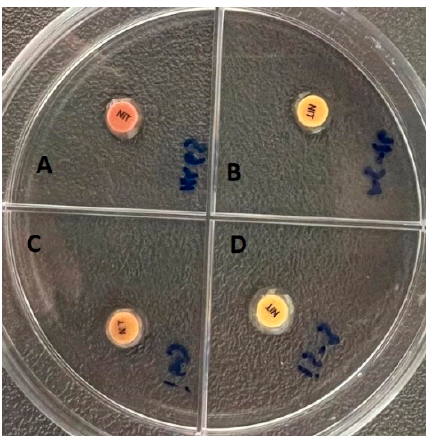
Figure 5. Chromogenic disk assay: ( A , C ) Beta-lactamase positive strains. ( B , D ) Beta-lactamase negative strains.